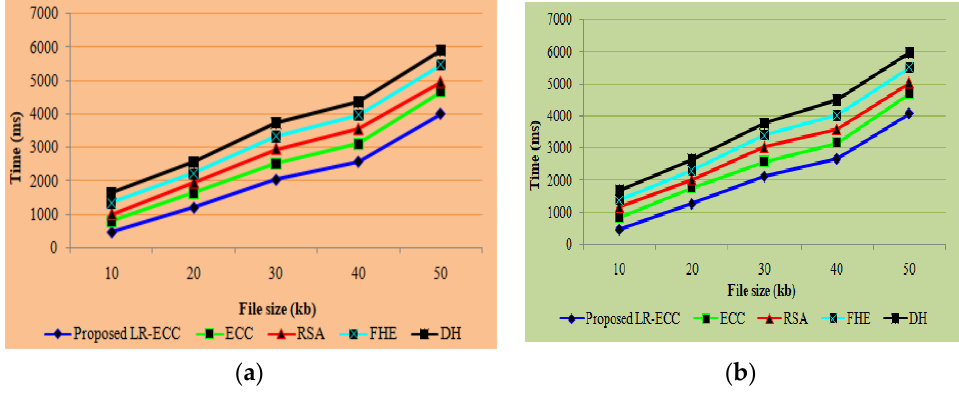
Figure 2. ( a ) Encryption time and ( b ) decryption time graph for the proposed method.